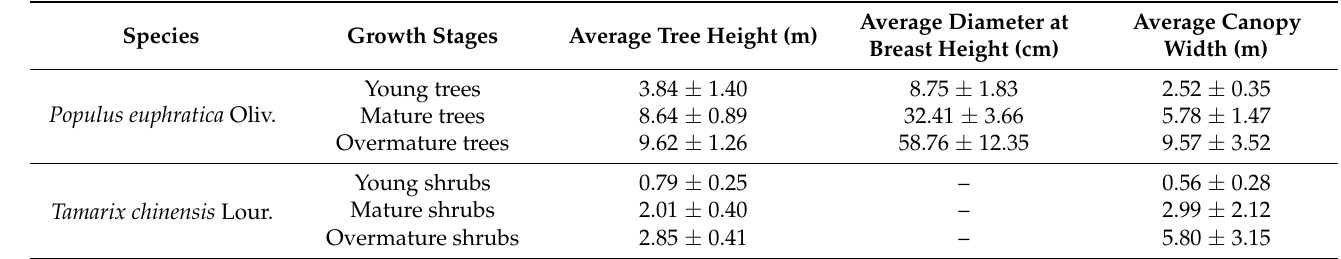
Table 1. Basic characteristics of sample trees in August 2019 (mean value ± standard deviation, n =